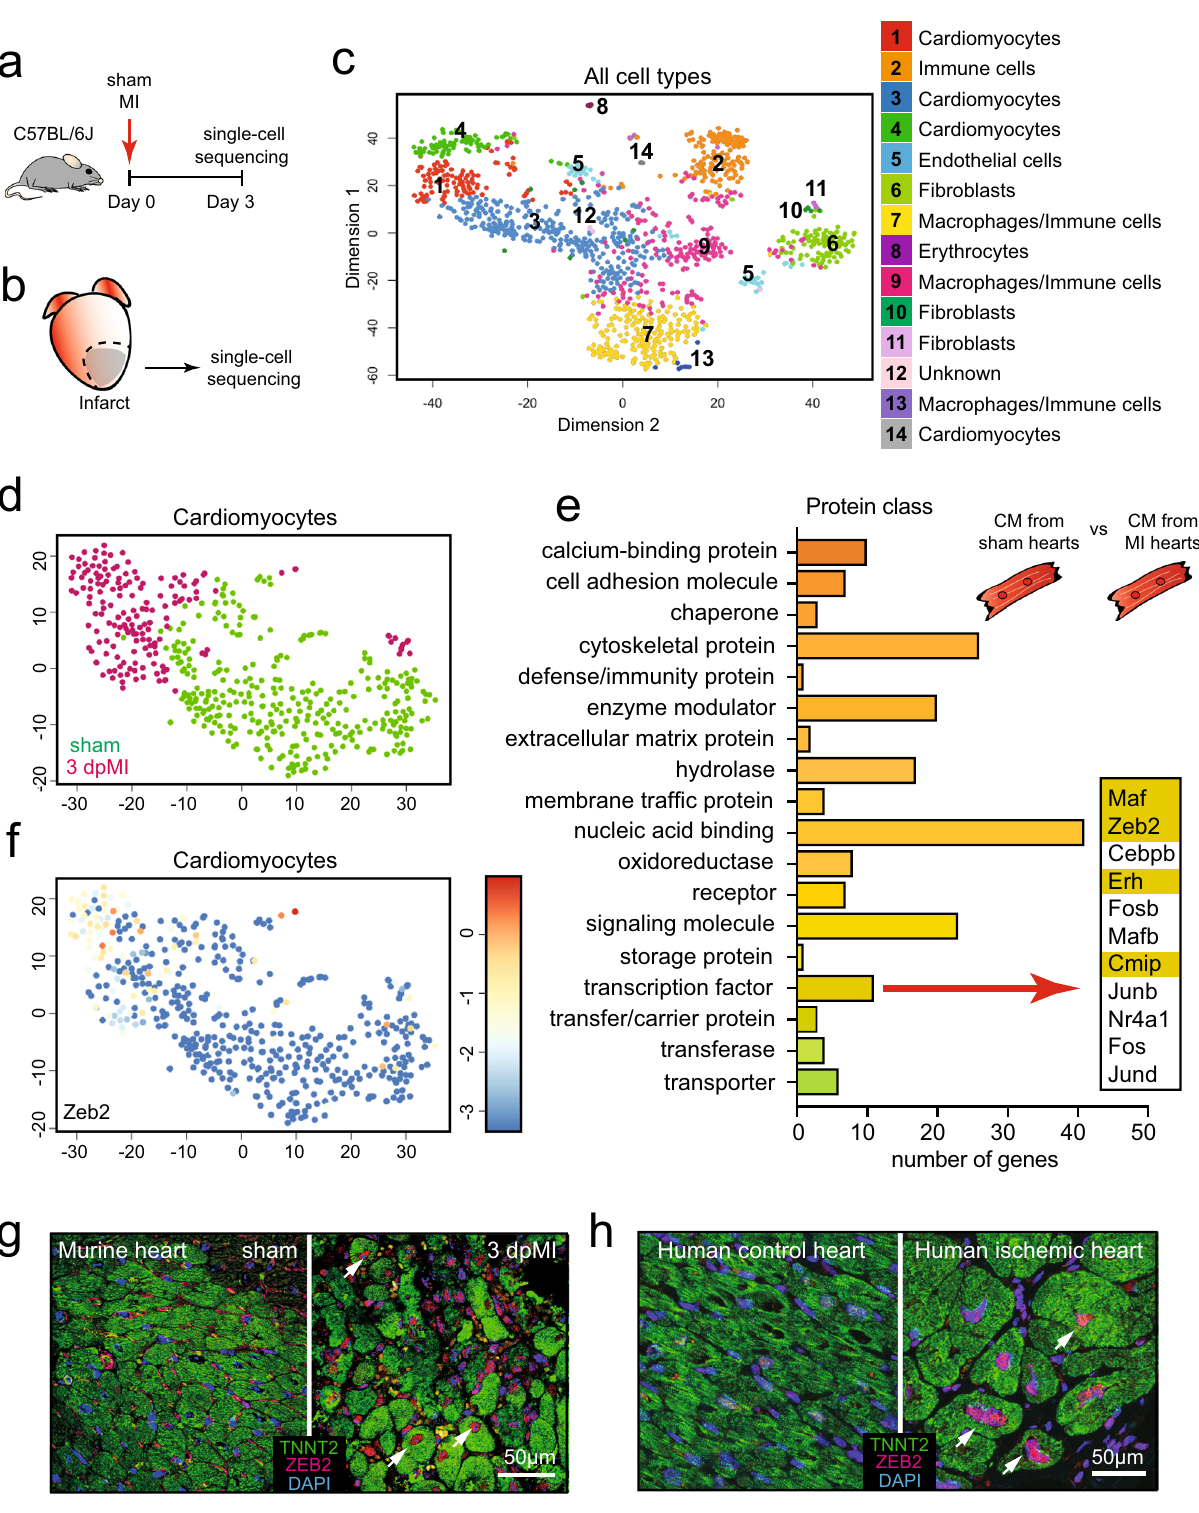
Fig. 1 ZEB2 is expressed in injured cardiomyocytes. a Study design. b Area of the heart subjected to single-cell sequencing. c - d t-SNE map indicating transcriptome similarities among all individual cells. c Different numbers and colors highlight different clusters identi fi ed by K-medoids clustering. d Colors highlight the conditions of the hearts from which the cells were derived (sham in green and 3 dpMI in pink). e The PANTHER Classi fi cation System analysis on enriched genes from injured cardiomyocytes when compared to sham. f t-SNE map showing the expression of Zeb2 across all cardiomyocytes from sham and 3 dpMI hearts. g Representative confocal images from sham and ischemic mouse hearts 3 dpMI stained for ZEB2, ACTN2, and DAPI. h Representative confocal images from human control and ischemic hearts stained for ZEB2, ACTN2, and DAPI. Expression is depicted as normalized transcript count on a color-coded scale. t-SNE indicates t-distributed stochastic neighbor embedding. White arrows show ZEB2 positive cardiomyocytes.